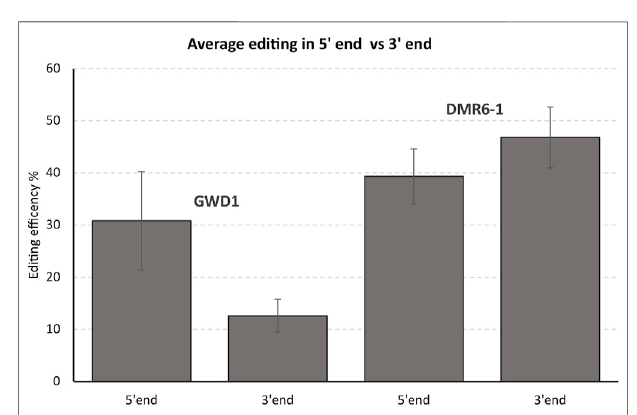
FIGURE 5 | Summarized effect of targeting the 5 ’ versus 3 ’ end of the GWD1 and DMR6-1 gene . The average editing ef fi ciency of the individual gRNAs targeting 5 ’ end and 3 ’ end of GWD1 and DMR6-1 (from 2 to 8 biological replicates were performed with std errors indicated).